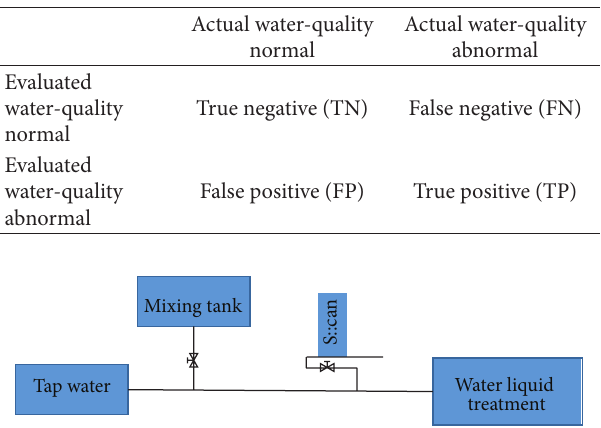
Figure 3: Experiments using the distribution